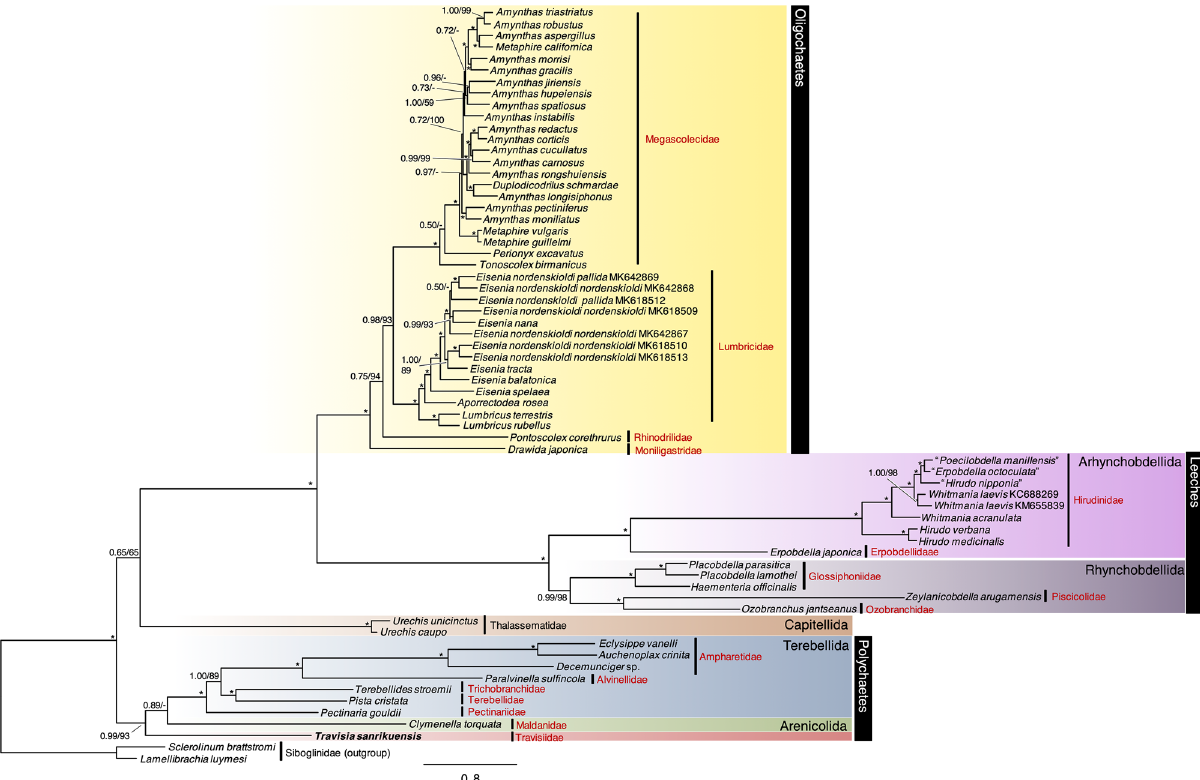
Figure 5. Bayesian phylogeny of a subset of Sedentaria based on the concatenated dataset, including the nucleotide sequences of 13 mitochondrial genome PCGs, 16S rRNA, and 12S rRNA (12,732 characters). Posterior probability (PP) followed by the percentage of the maximum likelihood bootstrap values (BS) above 50% is shown as numbers above branches. Asterisks indicate PP = 1.00 and BS = 100. Travisia sanrikuensis , for which the nucleotide sequence was newly obtained, is shown in